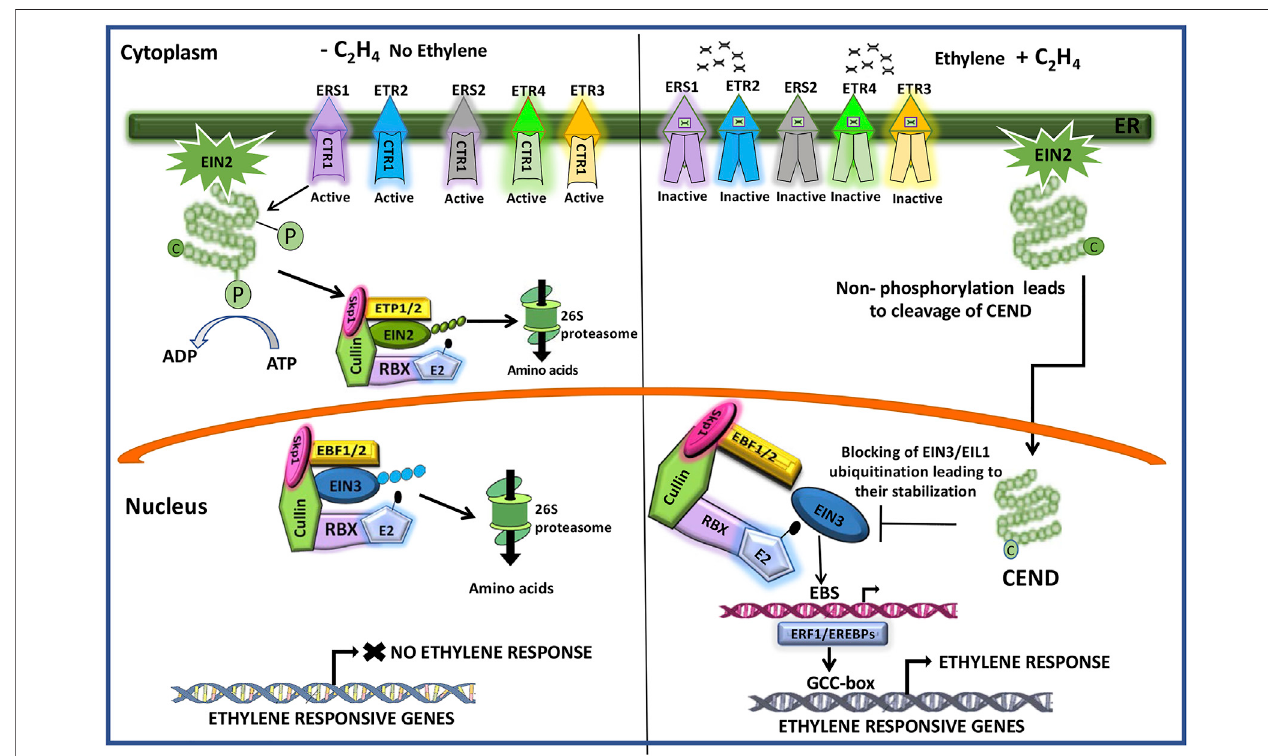
FIGURE 8 | Cartoon showing the molecular mechanism of ethylene action. The histidine kinase domain of CTR1 (constitutive triplet response1) of the ethylene receptors (ERS1, ERS2, ETR2, ETR3, ETR4) keeps on phosphorylating the CEND (C-terminal end) of the membrane bond protein EIN2 (ethylene insensitive2). This follows its recognition by the F-box proteins ETP1/2 (EIN2 targeting protein1/2) for ubiquitination by the SCF (Skp1-Culin-F-box) E3 ligase complex that additionally contains RBX, a RING box protein, and the E2 ubiquitin-conjugating enzyme and degradation of the ubiquitinated protein by the 26S proteosome system. Upon binding of ethylene to the receptors, the CTR1 kinase activity is inhibited, and the CEND gets detached and moves to the nucleus where it blocks the ubiquitination of EIN3 (ethylene insensitive3)/EIL1 (ethylene insensitive3 like1), preventing its 26S proteosomal degradation. Accumulation of EIN3 promotes it to bind to the EBS (Ein3/ EIL1-binding site) in the promoter of the ethylene responsive factor1 (ERF1) and other ethylene-responsive element binding proteins (EREBPs) to drive their expression. ERF1/EREBPsinturnsbindtotheGCC-boxinthepromoteroftheethylene-responsivegenes,leadingtoethyleneresponse.IntheabsenceofEIN2inthenucleus,EIN3 is recognized by the F-Box proteins EBF1/2 (EIN3-binding F-Box Protein1/2) for ubiquitination through the SCF (Skp1-Culin-F-box) E3 ligase complex, followed by its degradation by the 26S proteosome. Adapted from Ji and Guo